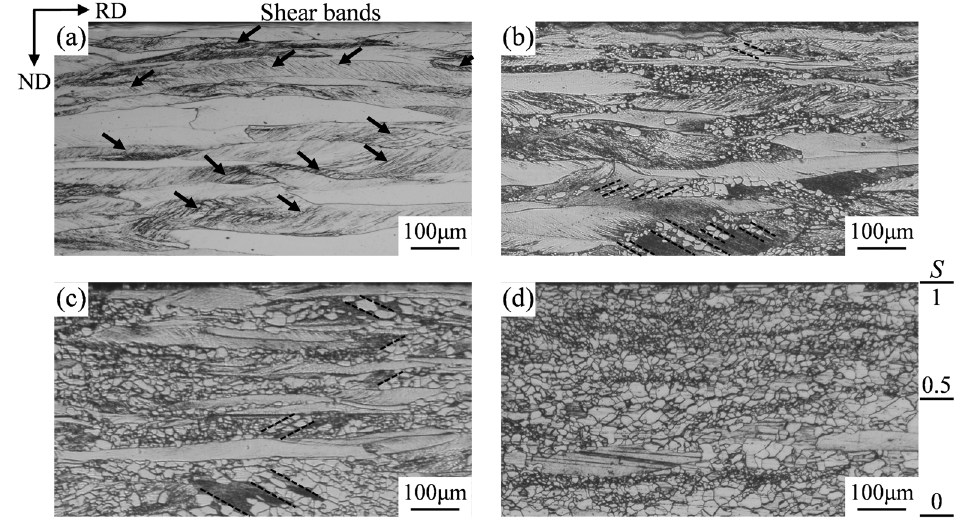
Figure 2. Optical microstructures of Fe-2.1 wt.% Si sheets after (a) cold rolling, and annealing at 650 °C for (b) 2 min, (c) 5 min, and (d) 10